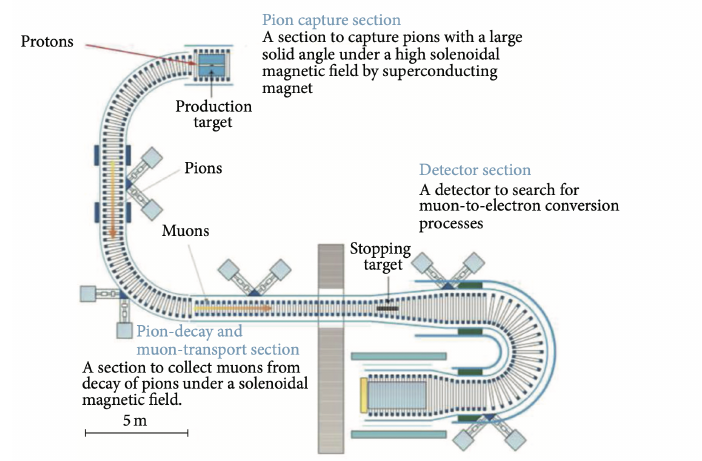
Figure 19. Schematic layout of COMET Phase-II (Figure from